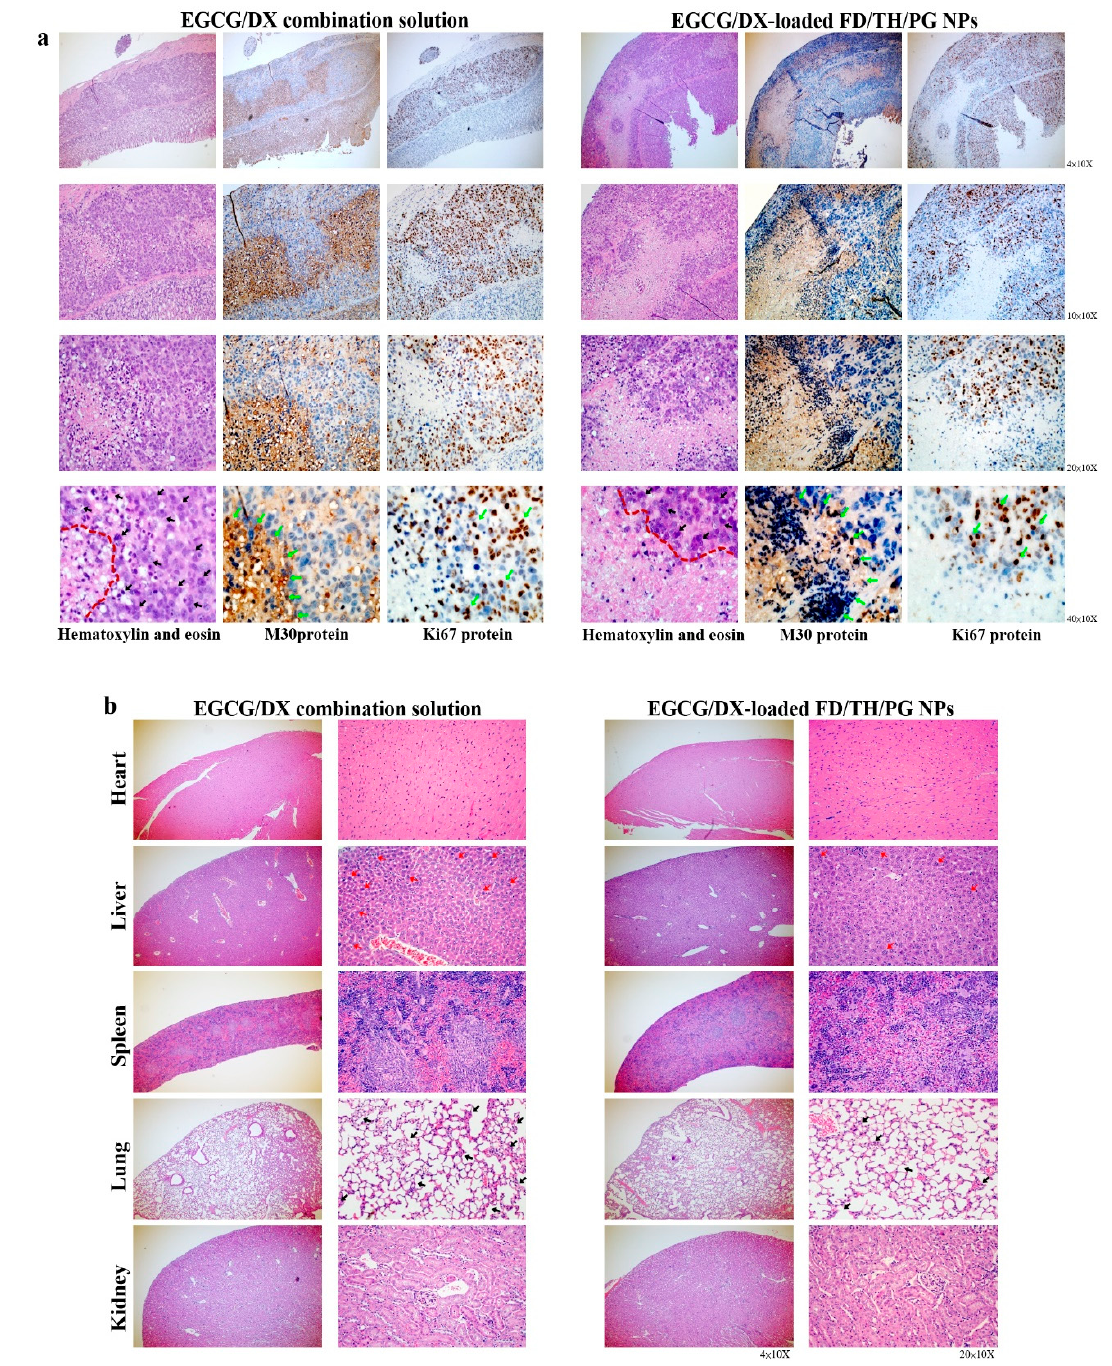
Figure 8. ( a ) Histological analysis and immunohistochemical analysis of Ki67 (proliferation marker) or M30 (apoptosis marker) of gastric tumor biopsy after treatment with EGCG/DX combination solution or EGCG/DX-loaded FD/TH/PG NPs; ( b ) Histological analysis of different organs in mice bearing gastric tumor after treatment with EGCG/DX combination solution or EGCG/DX-loaded FD/TH/PG NPs.